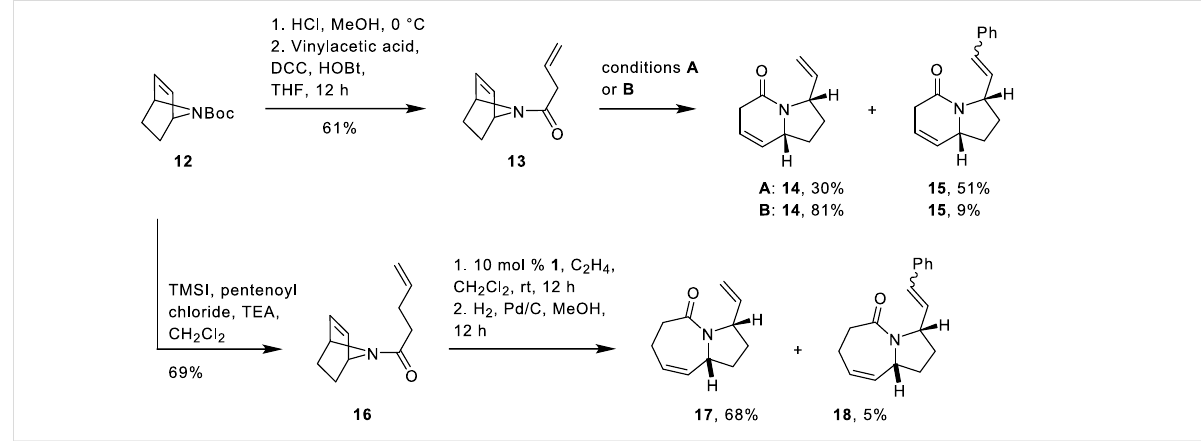
Scheme 3: RORCM of 7-azabicycloalkenes 13 and 16 to bicyclic scaffolds 14 , 15 , 17 and 18 . Conditions A : 10 mol % 1 , C 2 H 4 , 3 equiv styrene,